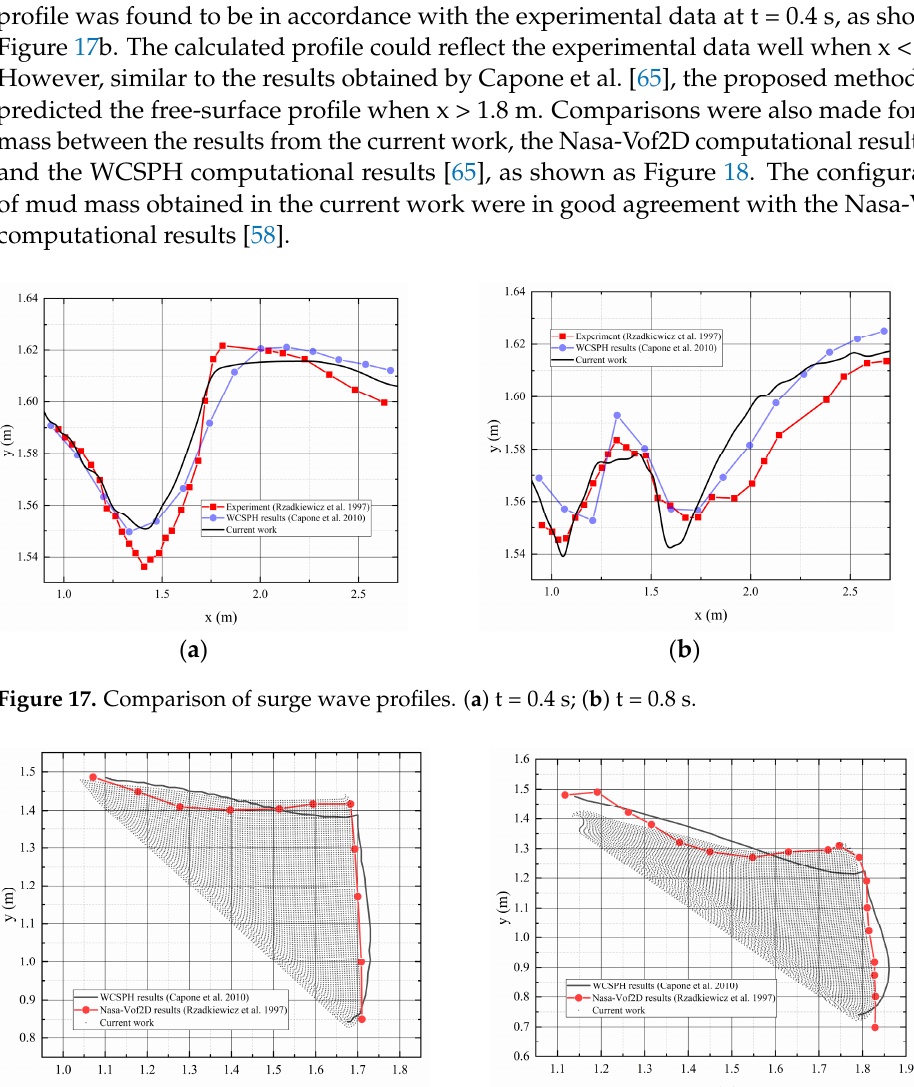
Figure 16. Evolution of the velocity and vorticity fields at typical instants.( a ) velocity field at t = 0.4 s; ( b ) velocity field at t = 0.8 s; ( c ) velocity field at t = 1.2 s; ( d ) vorticity field at t = 0.4 s; ( e ) vorticity field at t = 0.8 s; ( f ) vorticity field at t = 1.2 s.